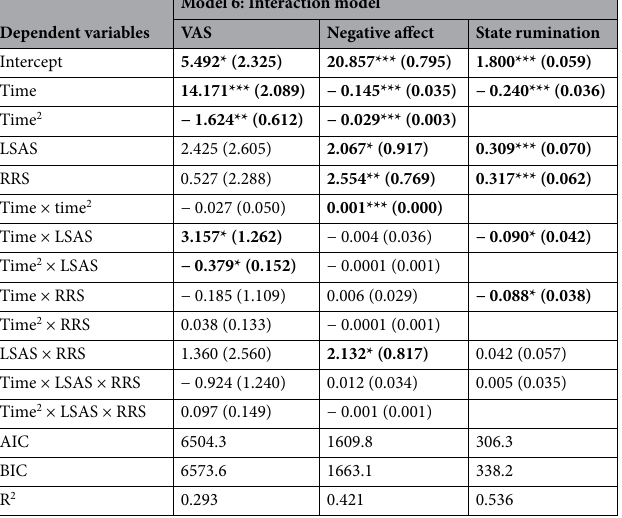
Table 2. Results of the exploratory Mixed Model 6 exploring the association between subjective stress, negative affect, state rumination and social anxiety (LSAS) and trait rumination (RRS) ( AIC Akaike Information Criterion, BIC Bayesian-Information-Criterion, R 2 variance explained by the fixed effects). Significant results are bold. * p < 0.05, ** p < 0.01, *** p < 0.001. Beta-estimates and standard errors in